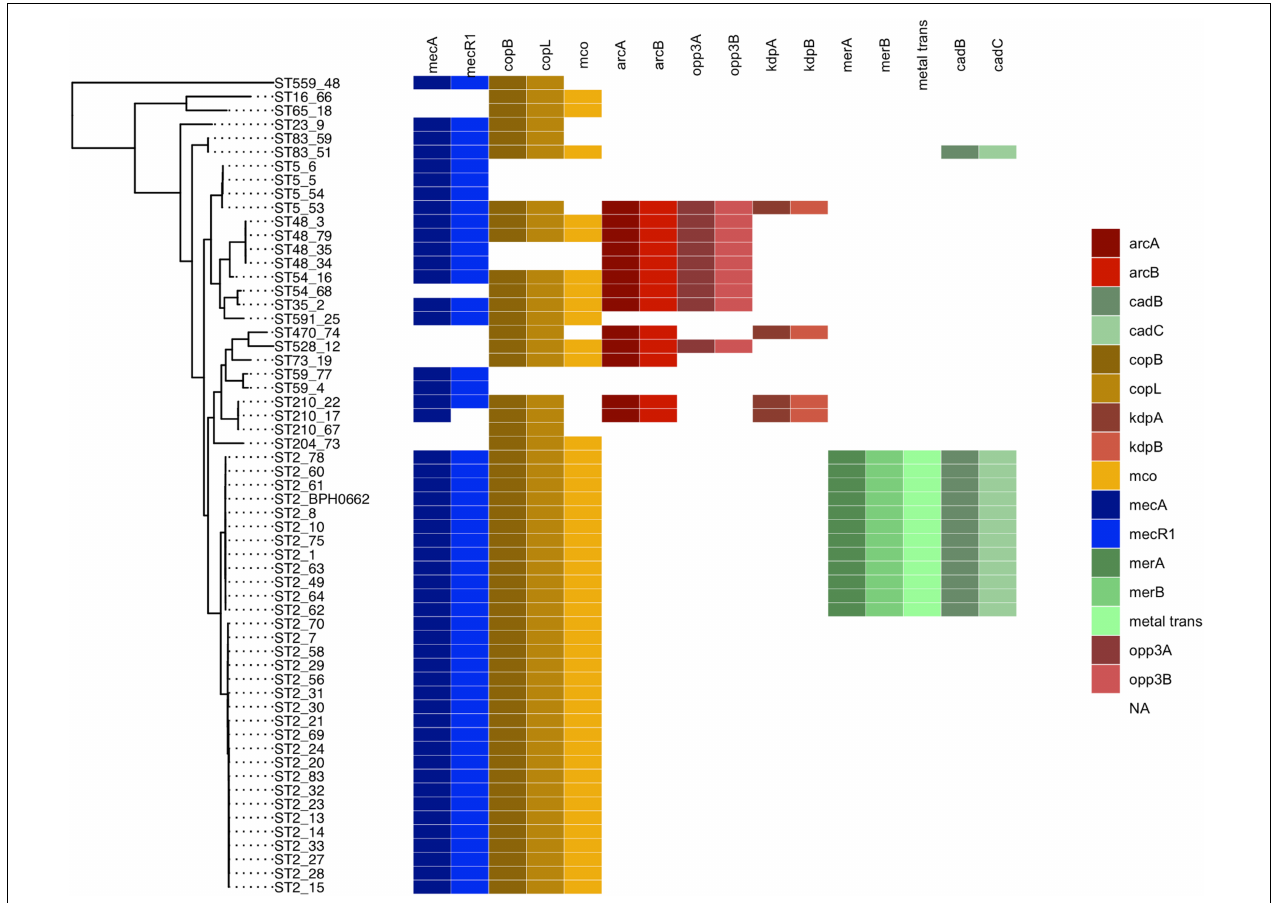
FIGURE 1 | Maximum likelihood phylogenetic tree constructed using core genome alignment from the 58 S. epidermidis clinical isolates. The phylogenetic tree is annotated with the isolate’s sequence type ST. Colored boxes to the right of each strain name illustrated the distribution of the SCCmec (blue), cop operon (yellow), ACME (red), and COMER-like element (green) characteristic genes among the S. epidermidis isolates. S. epidermidis BPH0662 used as reference strain in this phylogenetic